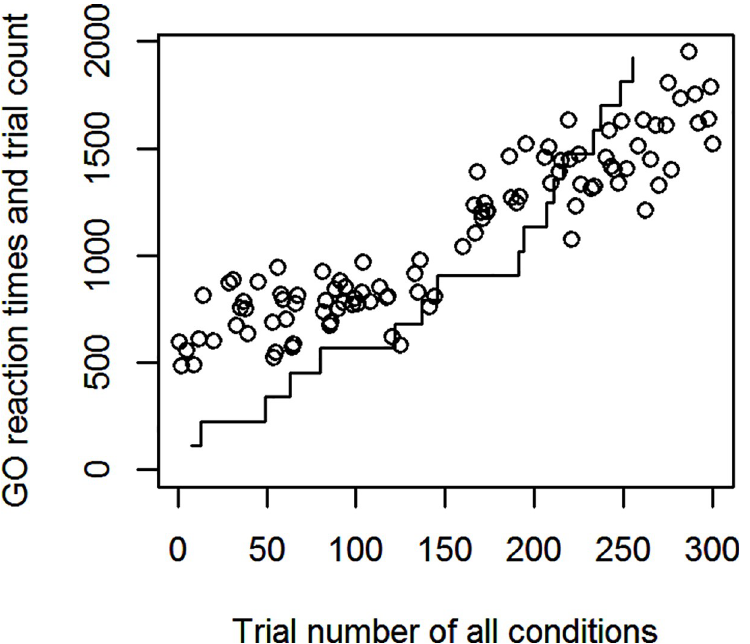
Fig 1. Go-RT slowing in Experiment 1. A participant’s Go-RTs for one condition. The line indicates the increasing number of Change-trials in that condition, the circles are Go-RTs.